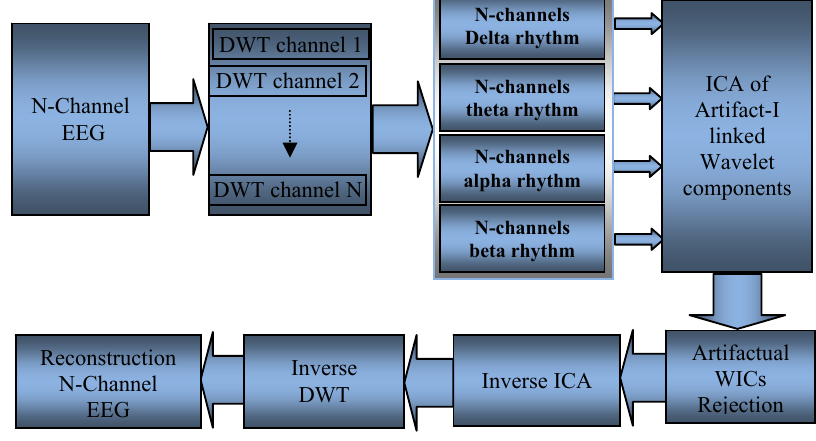
Figure 9. The combination structure between Wavelet transform and Independent Component Analysis.